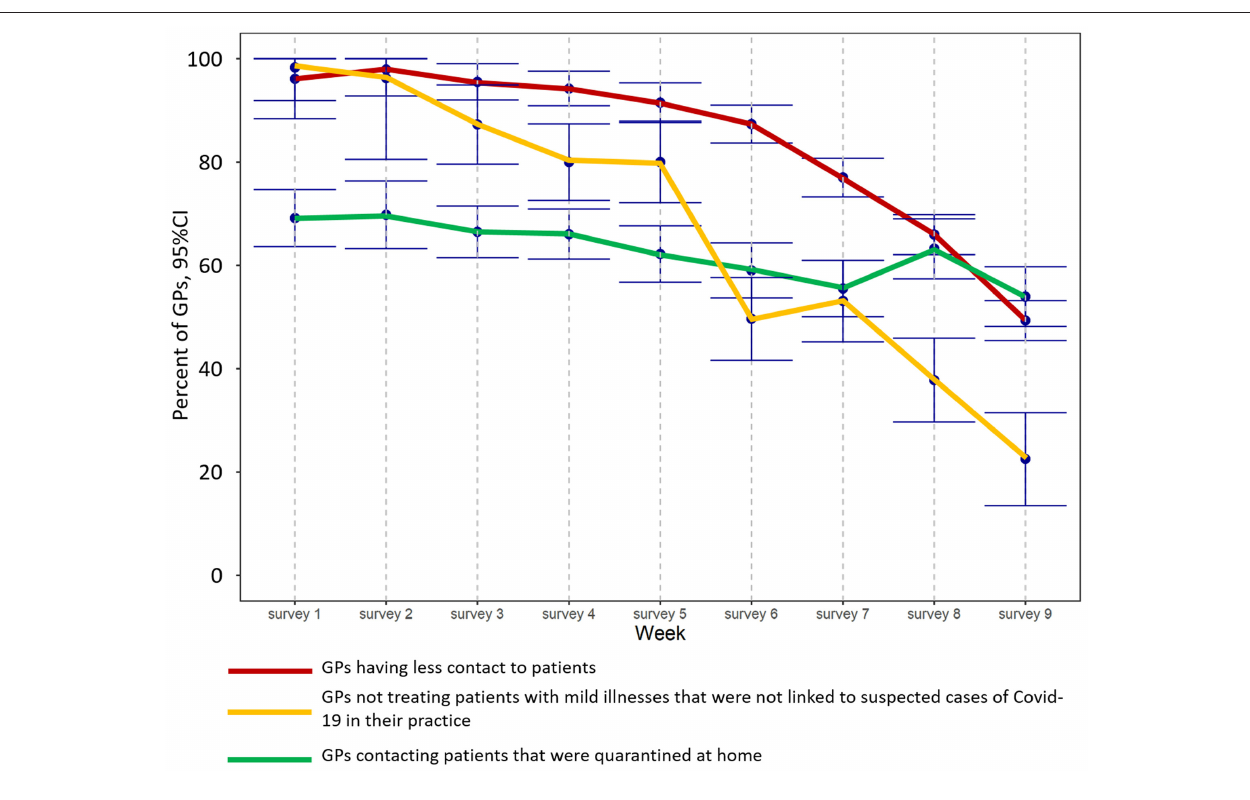
FIGURE 2 | Change in type of work performed during the study